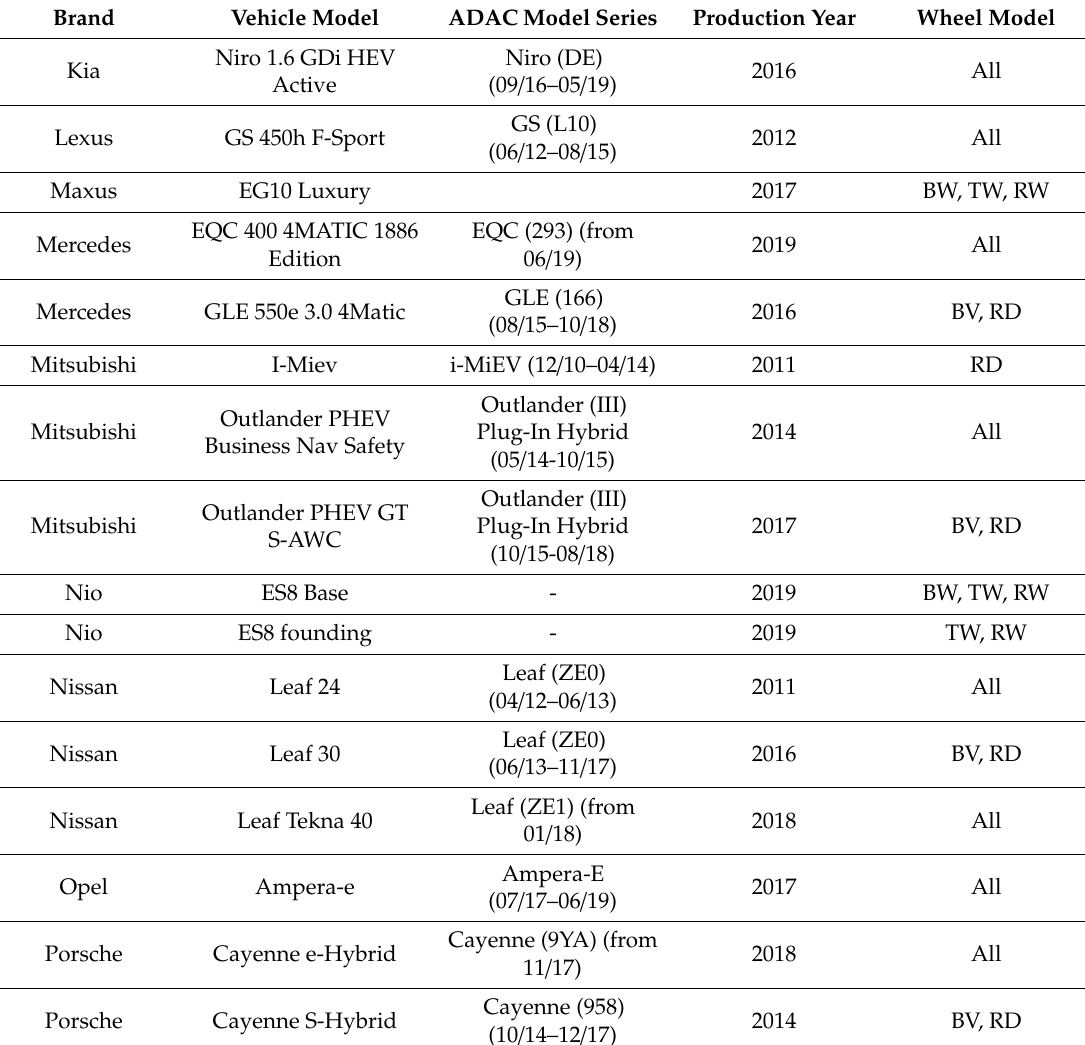
Table A2. Database overview, part